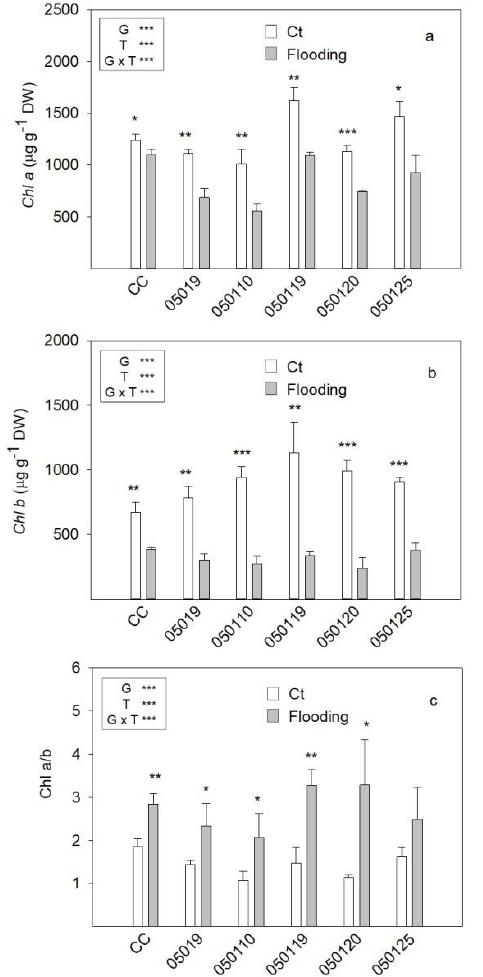
Figure 2. ( a ) Chlorophyll a ( Chl a) concentration, ( b ) chlorophyll b ( Chl b) concentration, and ( c ) the Chl a/b ratio in young and well developed (fully expanded) leaves of five citrus hybrids grown for 35 days in the non-stressed (Ct) or flooding treatment. Value are the means of six independent seedlings ( n = 6). In each hybrid, comparisons among treatments were made using Fisher’s least significance difference (LSD) test. * p < 0.05, ** p < 0.01, *** p < 0.001. CC: Carrizo citrange; G: genotype, T: treatment.